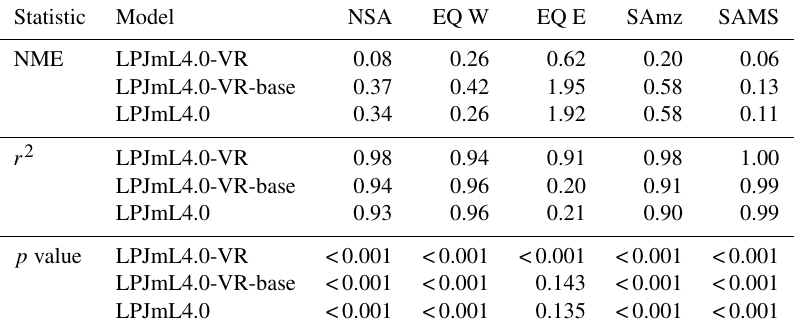
Table B3. Normalized mean error (NME), coefficient of determination ( r 2 ) and p value of F statistic piecewise calculated for the simulated ET of the different LPJmL model versions used in this study and continental-scale gridded ET products within five regional climatological clusters. With respect to Fig. 3 comparisons are based on the monthly mean of corridors shown, i.e. (1) the monthly mean of all outputs produced by one LPJmL model version but forced with different climate inputs and (2) the monthly mean of all continental-scale gridded ET data